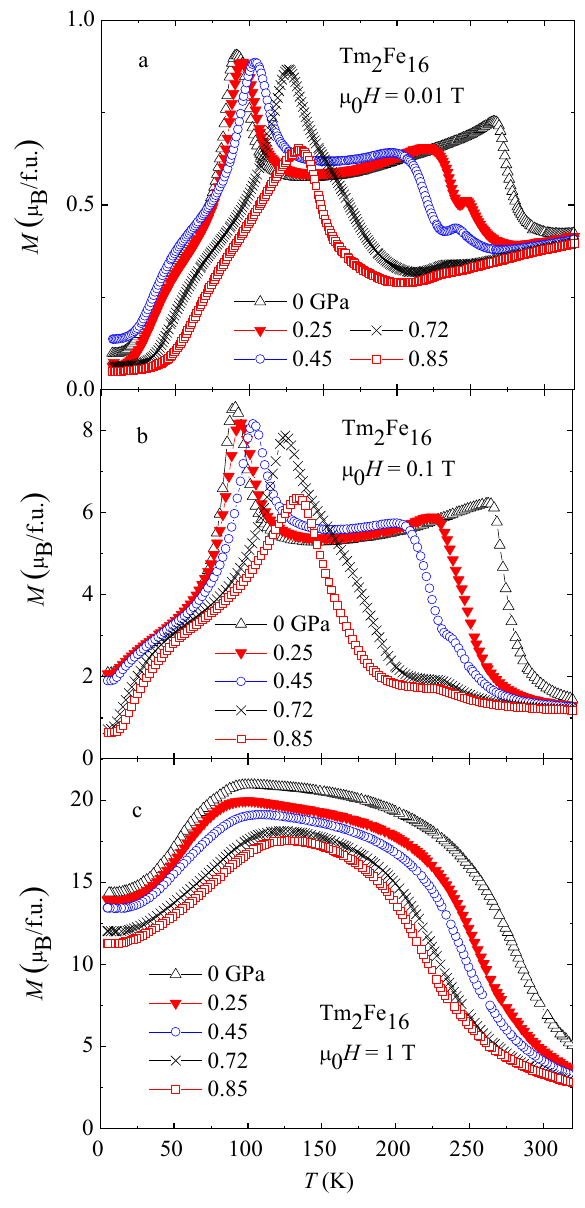
Fig. 1. Temperature dependences of magnetization of the Tm 2 Fe 16 polycrystal measured in a field of 0.01 T (a), 0.1 T (b) and 1 T (c) under different pressures: 0, 0.25, 0.45, 0.72, 0.85 GPa